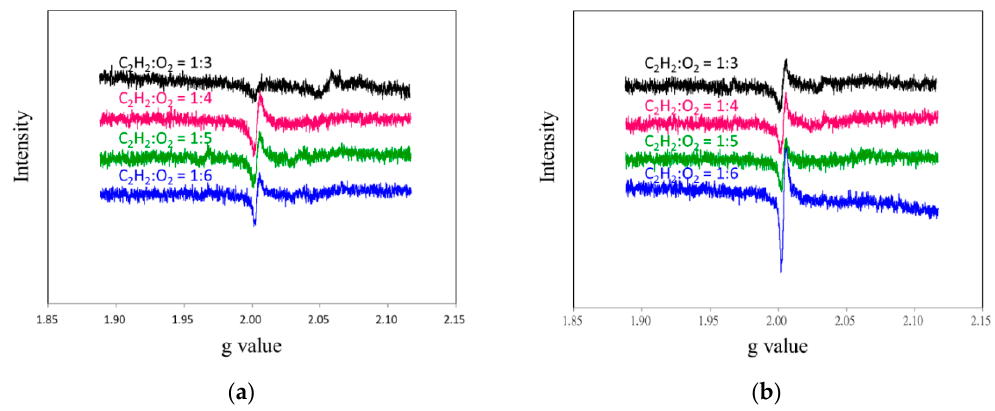
Figure 5. EPR spectra of visible-light-illuminated TiO 2 powders produced by the FFCVC method with ( a ) C 2 H 2 600 sccm and with ( b ) C 2 H 2 800 sccm.